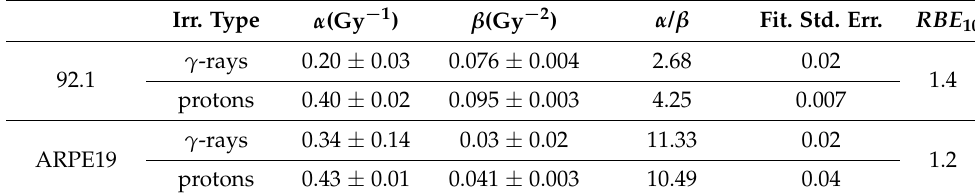
Table 1. Survival curve parameters measured for proton and gamma irradiation of the 92.1 and ARPE-19 cell line. The statistical parameters of the double exponential fit function and the values of the derived RBEs are